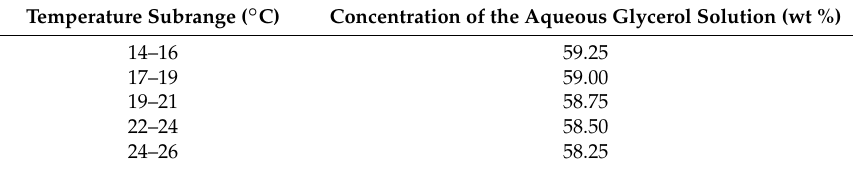
Table 2. Temperature ranges for a refractive index matching of an aqueous glycerol solution and Elastosil ® RT